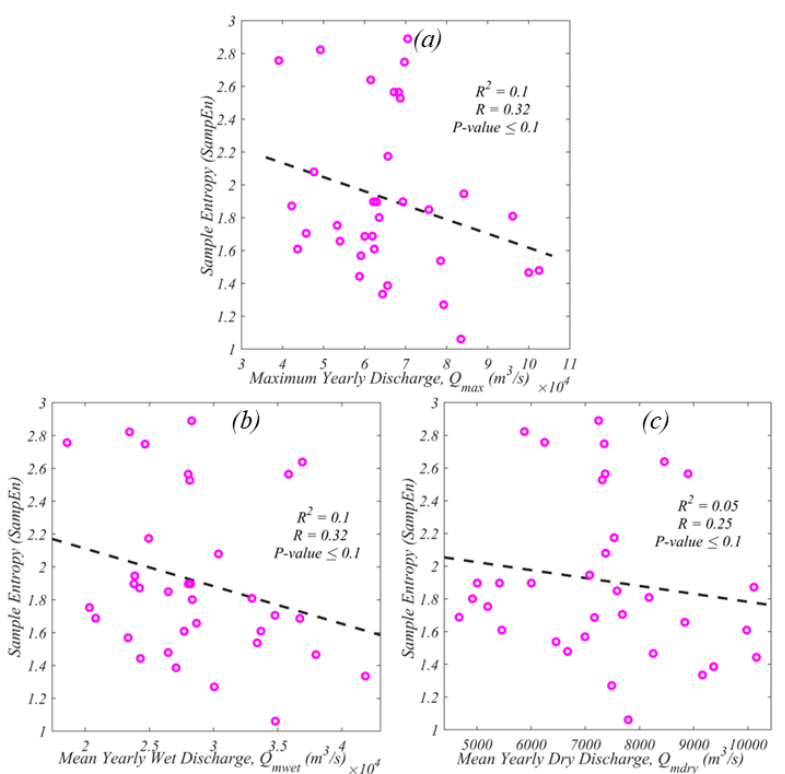
Figure 9. Correlation between Sample Entropy ( SampEn ) and ( a ) Yearly maximum discharge ( Q max